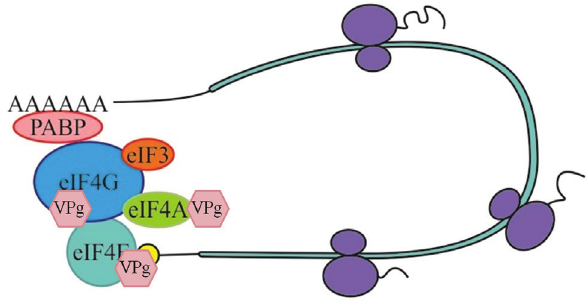
Figure1 -Hosttranslationfactorstargetedbygenome-linkedviralprotein (VPg) in canonical eukaryotic translation. VPg recruits the translation ini- tiation complex for viral genome translation through its specific interac- tion with eIF4E/eIF(iso)4E. VPg also binds to eIF4G/eIF(iso)4G, which may act enhancing VPg-eIF4E/eIF(iso)4E interactions. Potyvirus VPg protein interacts with DEAD-box RNA helicase-like proteins closely re- lated to A. thaliana eIF4A genes. RNA helicase, as part of the eIF4F trans- lation complex, might be also involved in viral genome